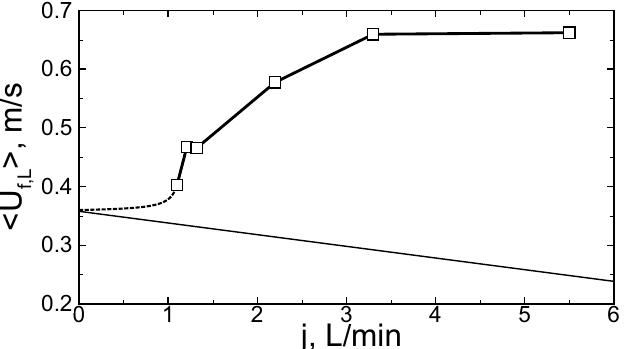
Figure 3. Dependence of flame speed averaged over the channel length on the flow rate. Signs— experimental data. Dashed line—approximation with account of normal burning rate value (at j = 0). Thin solid line—estimation of the flame speed in one-dimensional